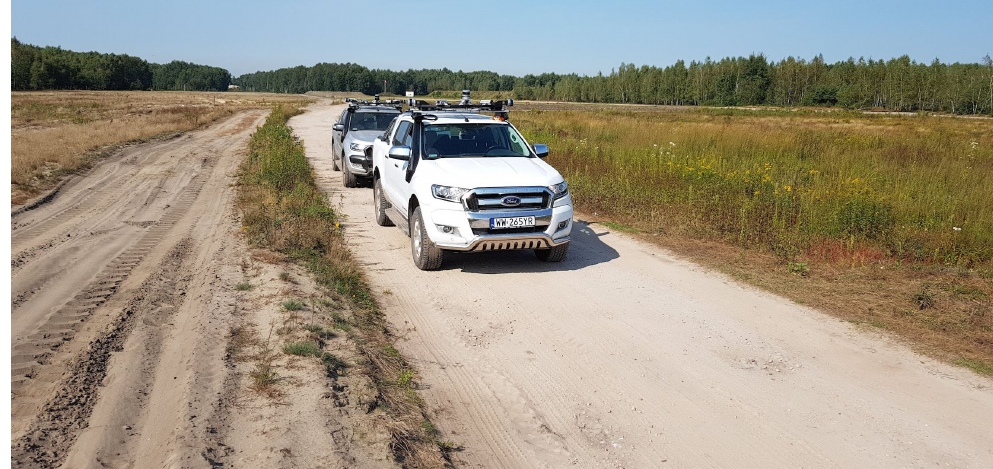
Figure 1. Łukasiewicz-PIAP ATENA demonstrator of technology. The traversability estimation algorithm used in ATENA transforms the point cloud to a 2.5D grid-based map. A sample of a point cloud from 3D is shown in Figure 2. The main problems occur when the ATENA system is planning clear paths in the field covered by vegetation.